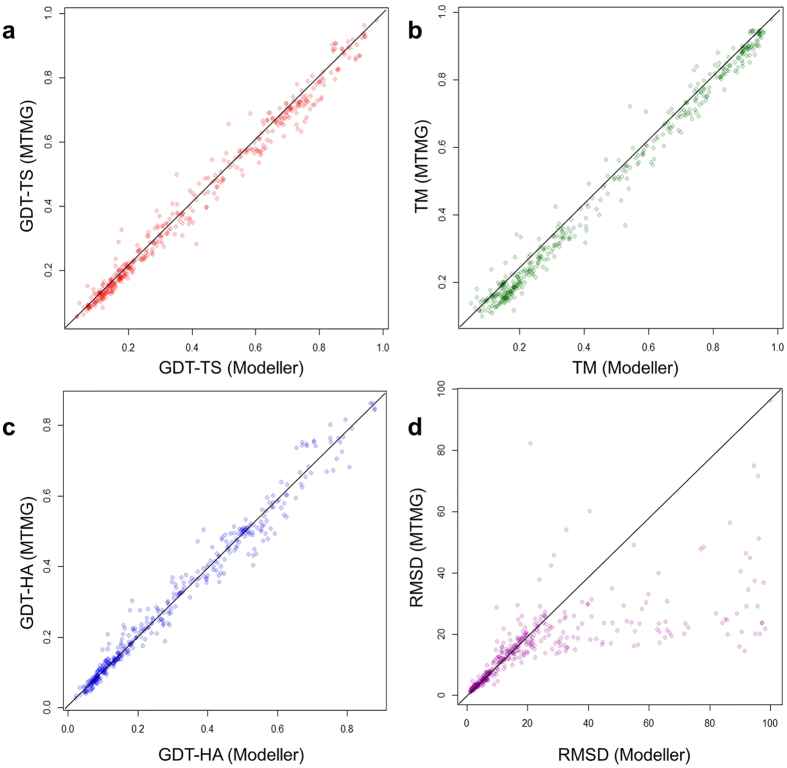
The scatter plot of GDT-TS scores, TM-scores, GDT-HA scores and RMSDs of the models predicted by MTMG against those of Modeller on CASP11 targets.The scores of Modeller models are plotted against MTMG models. X-axis represents the scores of Modeller models and Y-axis represents the scores of MTMG models.